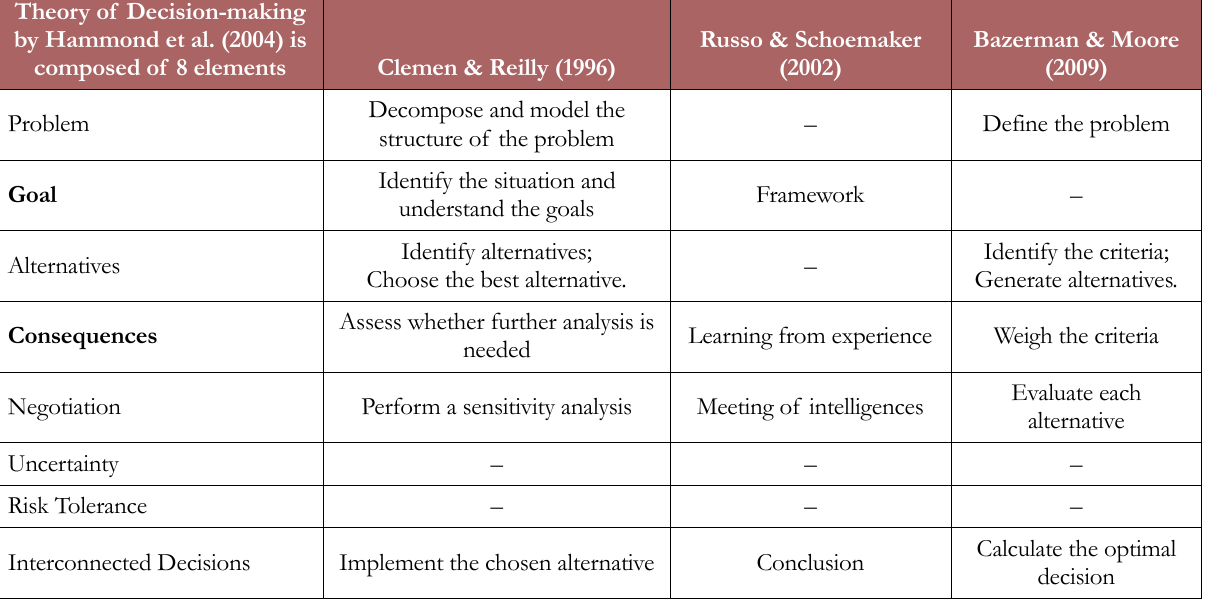
Table 4. Constructs and concepts of rationality (Elbanna, 2006: page